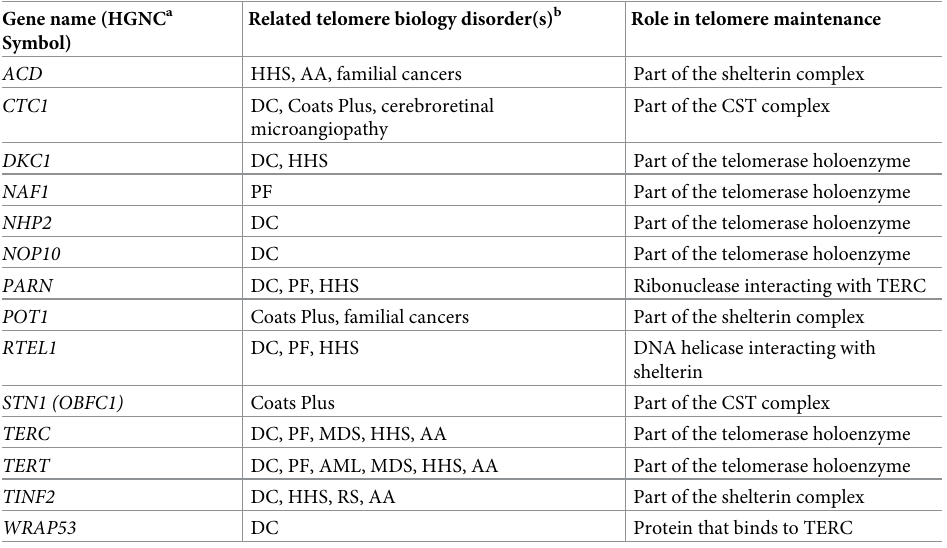
Table 1. Genes currently implicated in telomere biology